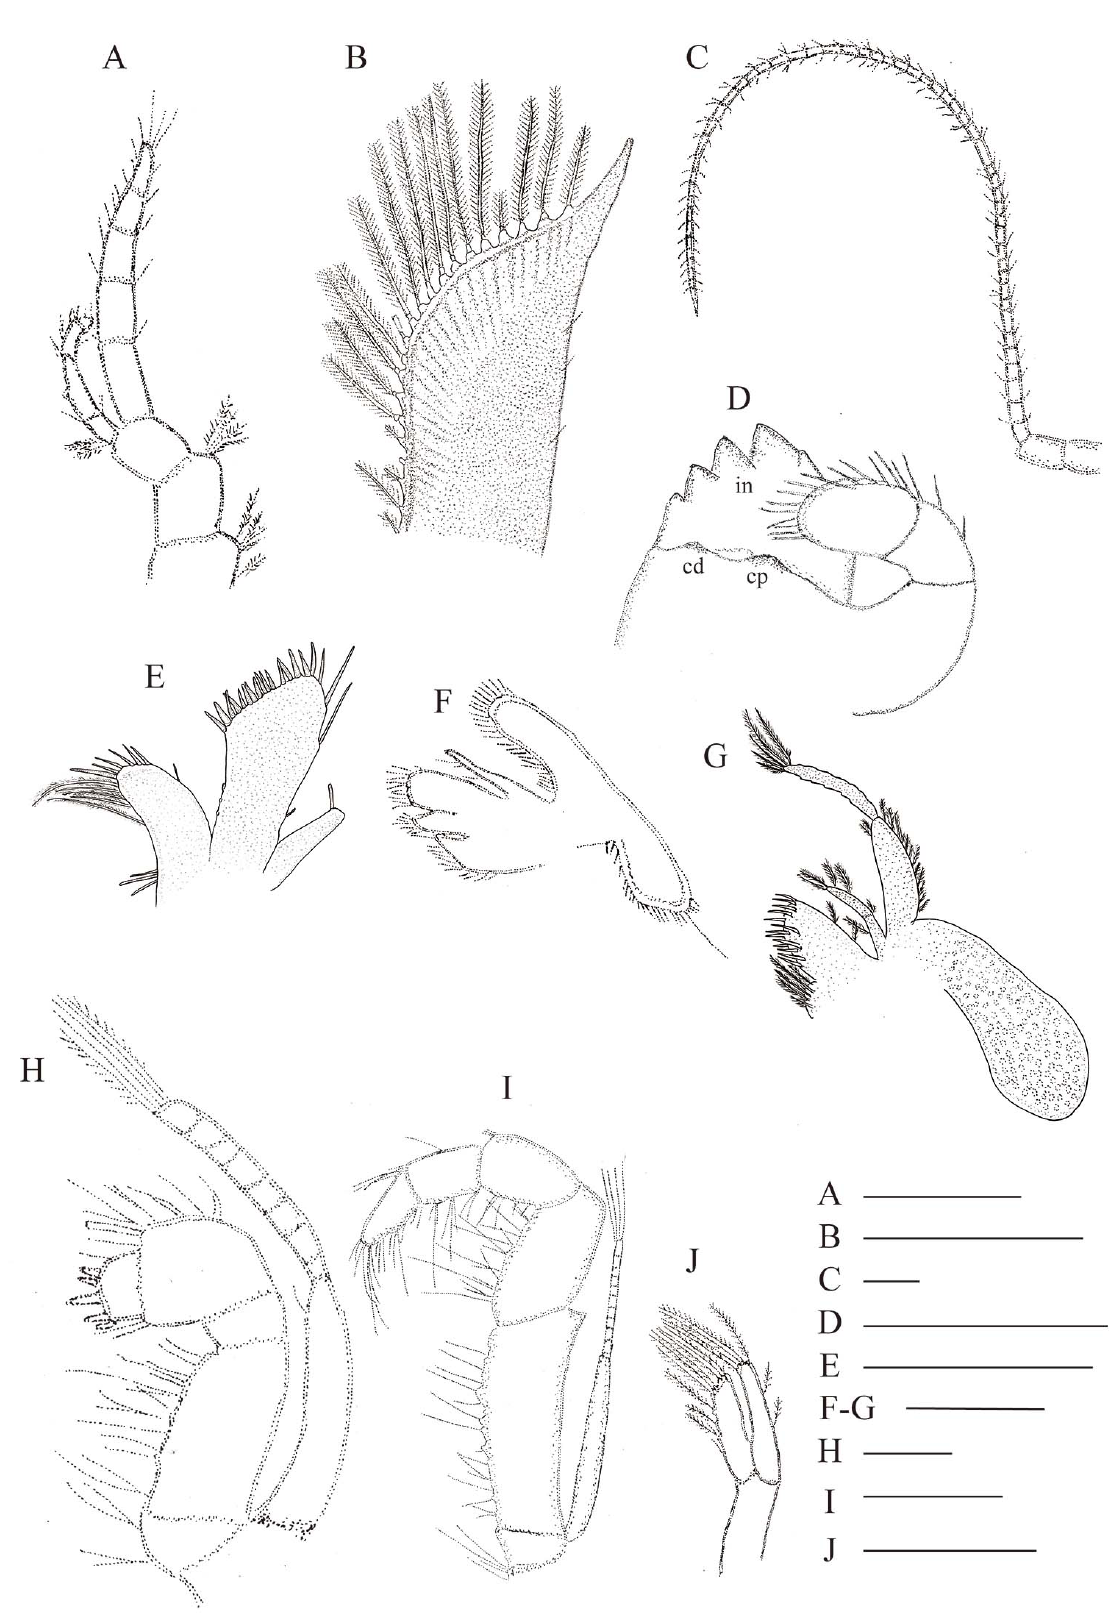
Figure 4. Juvenile Stage II of Austropotamobius torrentium . ( A ) Antenna 1, dorsal view; ( B ) antennal scale, dorsal view; ( C ) flagellum of antenna 2, dorsal view; ( D ) mandible, view of inside of mouth; ( E ) maxilla 1, oral view; ( F ) maxilla 2, oral view; ( G ) first maxilliped, oral view; ( H ) second maxilliped, oral view; ( I ) third maxilliped, oral view, ( J ) pleopod. cd, caudal process; cp, cephalic process; in, incisor ridge. Scale bars: 0.25